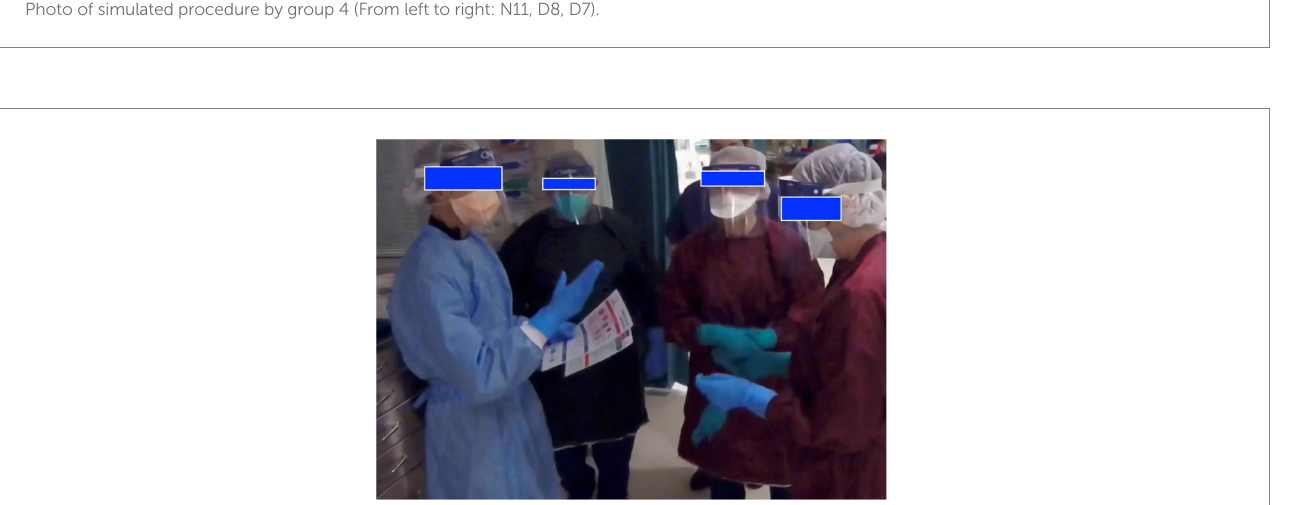
FIGURE 4 Role allocation occurring during clip 2 (referred to in quote 19).